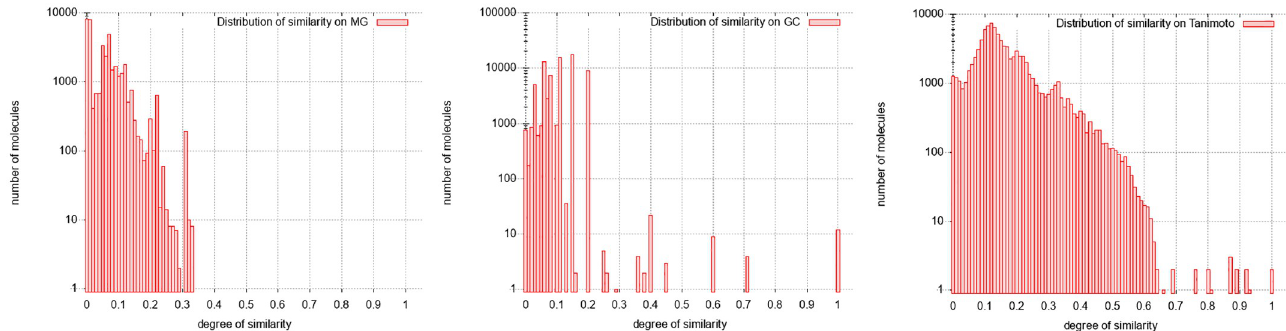
Fig 16. Distribution of similarity on Amphotericin B. From left to right: Distribution with molecular graphs (MG), graphs of cycles (GC) and Tanimoto Coefficient (TC).